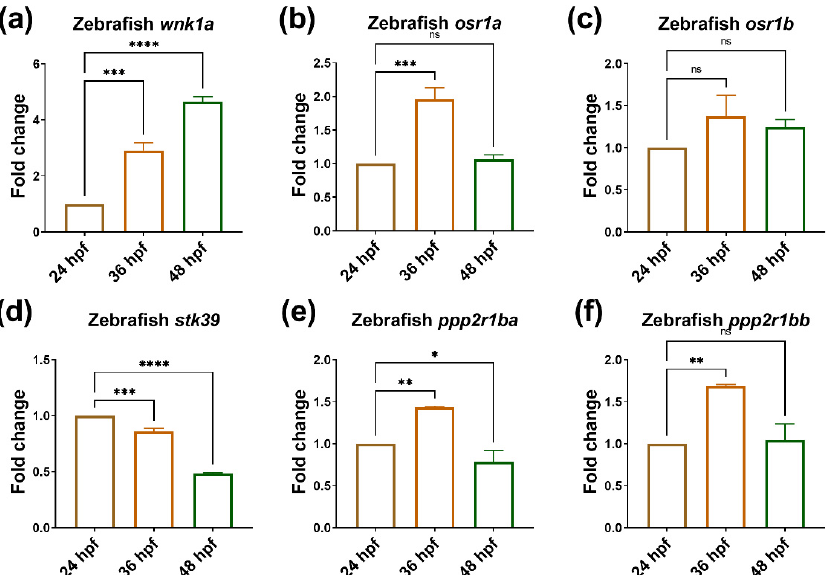
Figure 1. During embryonic angiogenesis, wnk1a and osr1b are upregulated. The expression of wnk1 and its downstream effectors during embryonic angiogenesis. ( a ) wnk1a , ( b ) osr1a , ( c ) osr1b , ( d ) stk39 , ( e ) ppp2r1ba and ( f ) ppp2r1bb in zebrafish embryos stages from 24 h post-fertilization (hpf) to 48 hpf during embryonic angiogenesis. For each experiment, we performed three replicates, and for each qPCR, there were triplicates for each sample. Thirty larvae were included in each time point. One- way ANOVA analysis followed by multiple analysis was used to identify the statistical significance between groups; *: p ≦ 0.05; **: p ≦ 0.01; ***: p ≦ 0.001; ****: p ≦ 0.0001; ns: no-significance.